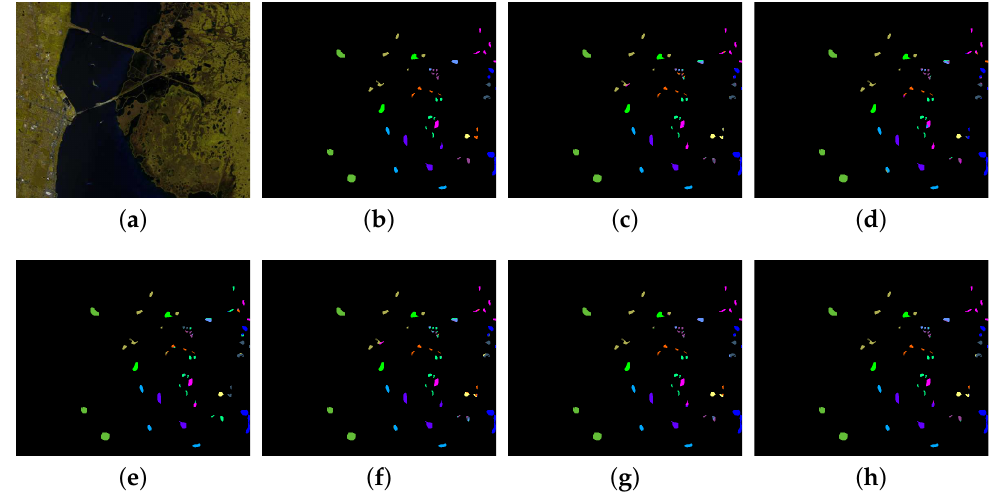
Figure 10. KSC data set. ( a ) False-color composite image. ( b ) Ground reference map. The classification maps obtained by the ( c ) 3-D CNN (87.91), ( d ) FCLFN (88.60), ( e ) DFFN (89.35), ( f ) DenseNet (91.04), ( g ) ResNet (95.24) and ( h ) MPRN (96.00). Note that the overall classification accuracies (in %) are shown in brackets.